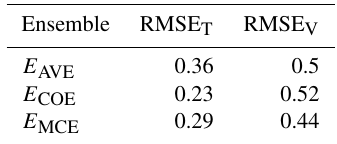
Table 7. Performance comparison of different methods on KMA data, RMSE on training (RMSE T ) and validation (RMSE V )